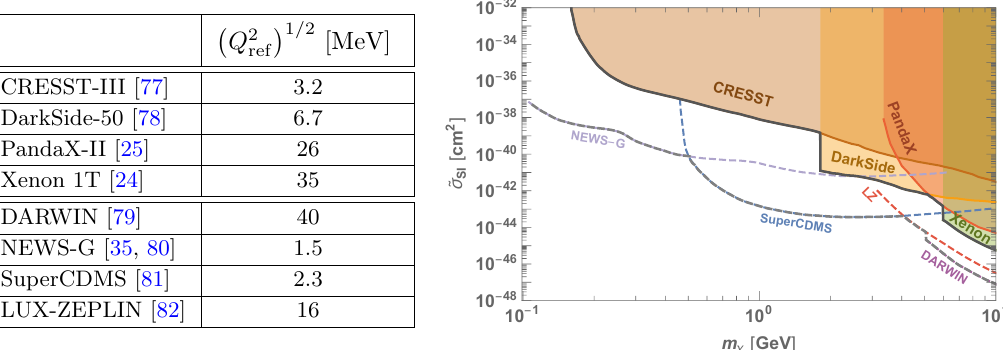
Figure 1 . Left panel . Current (upper part) and future (lower part) direct detection experiments, along with a reference scale for the momentum transfer. Right panel . Current limits (solid lines) and projected sensitivities (dashed lines) to the nucleon cross section assuming momentum-independent scattering . Limits for the zero momentum limit are thus obtained by re-scaling these reported results as in eq.